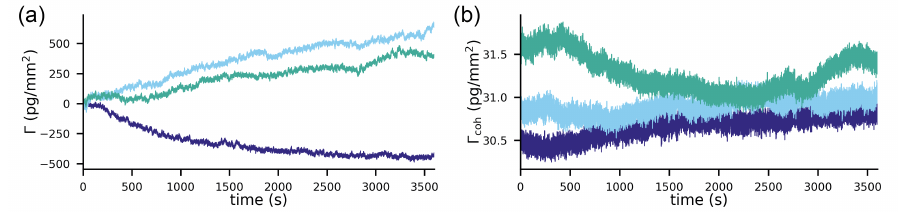
Figure 5. Comparison of the resolution of an unreferenced refractometric and a diffractometric biosensor subject to the very same experimental conditions: ( a ) refractometric output for three different experiments in PBS-Tbuffer at a flow rate of 5 µ L/min with 0.1 numerical aperture (NA) molograms (2-mm focal distance). ( b ) Simultaneous diffractometric output for the same three experiments: the noise of the diffractometric baselines is roughly three orders of magnitude smaller than the refractometric